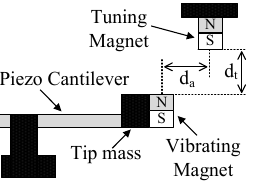
Figure 9. Schematic representation of the magnetic forces based MTT proposed in [10].